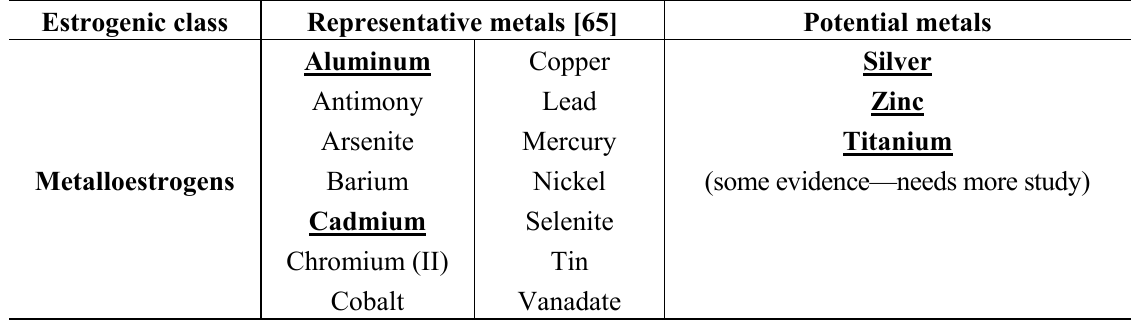
Table 2. Examples of select metals with known or suspected estrogenic activity